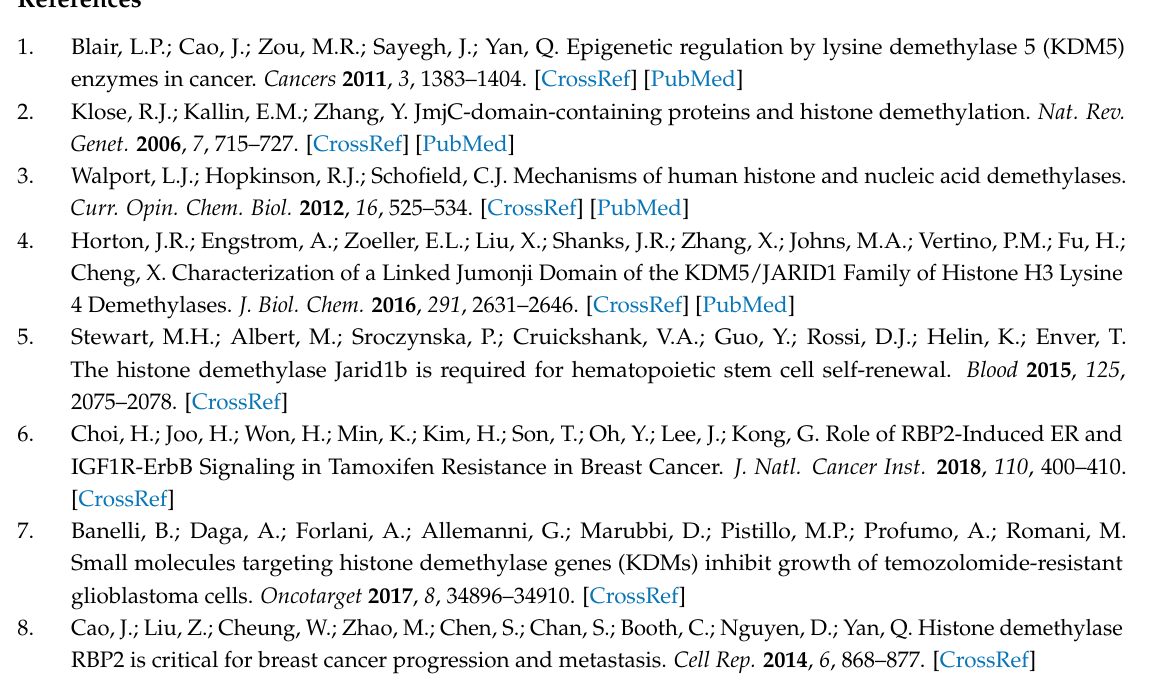
Table S1: Primers for promoter specific ChIP-qPCR and RT-qPCR using in this paper. Figure S1: Chemical structures of compounds were evaluated in this study, Figure S2: KDM5A is the direct target of compound 1 , Figure S3: Compound 1 increases the thermal stabilization of KDM5A in cell lysates, Figure S4: Compound 1 inhibits cell growth as determined by a colony formation assay, Figure S5: The cytotoxicity effect of compound 18 on breast cancer cells and normal cells, Figure S6: KDM5A Knockdown reduces 1 - or 18 -induced cell